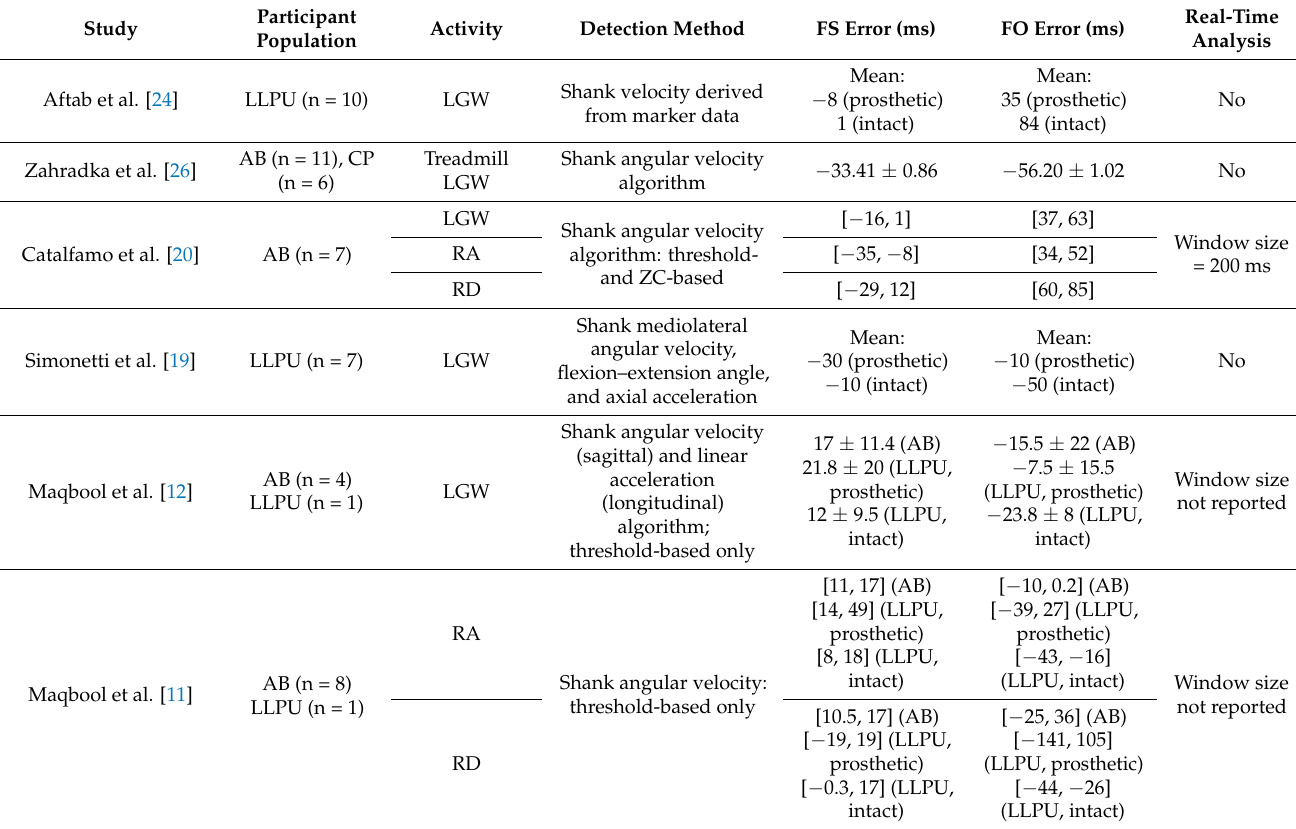
Table 5. Summary of results of previous studies with at least partially comparable